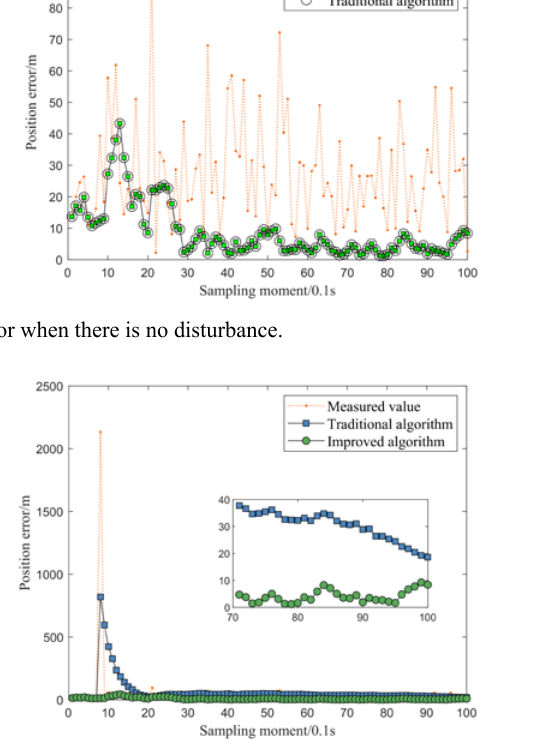
Fig. 6. Positioning error when there is